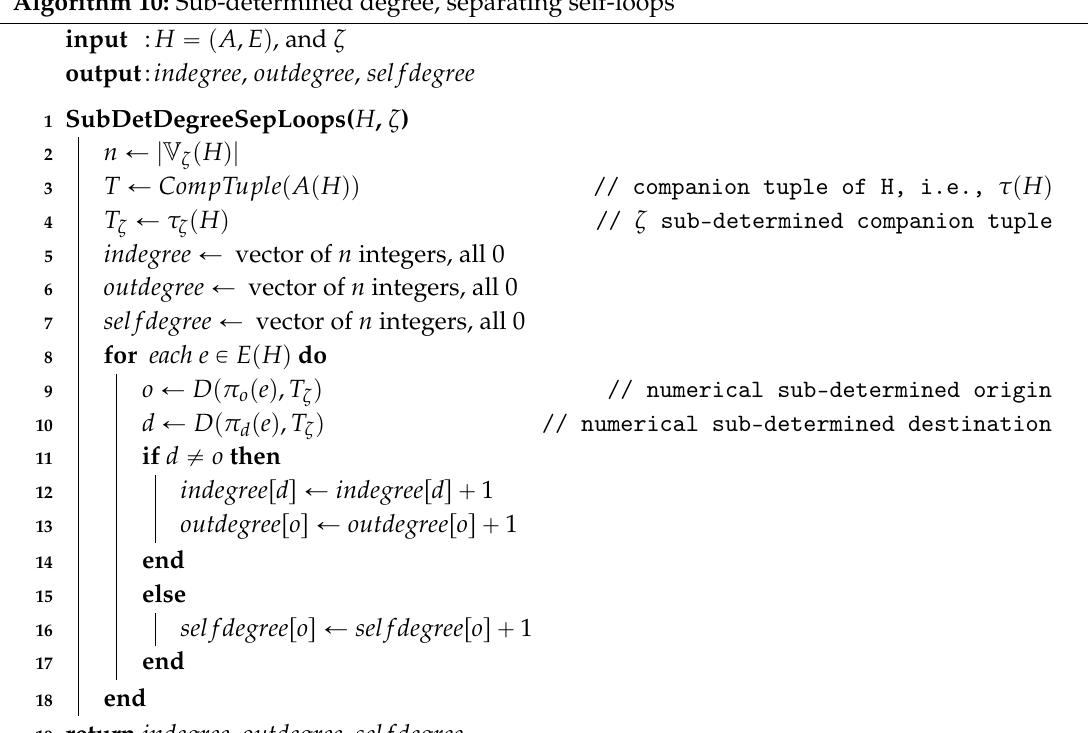
Algorithm 10: Sub-determined degree, separating